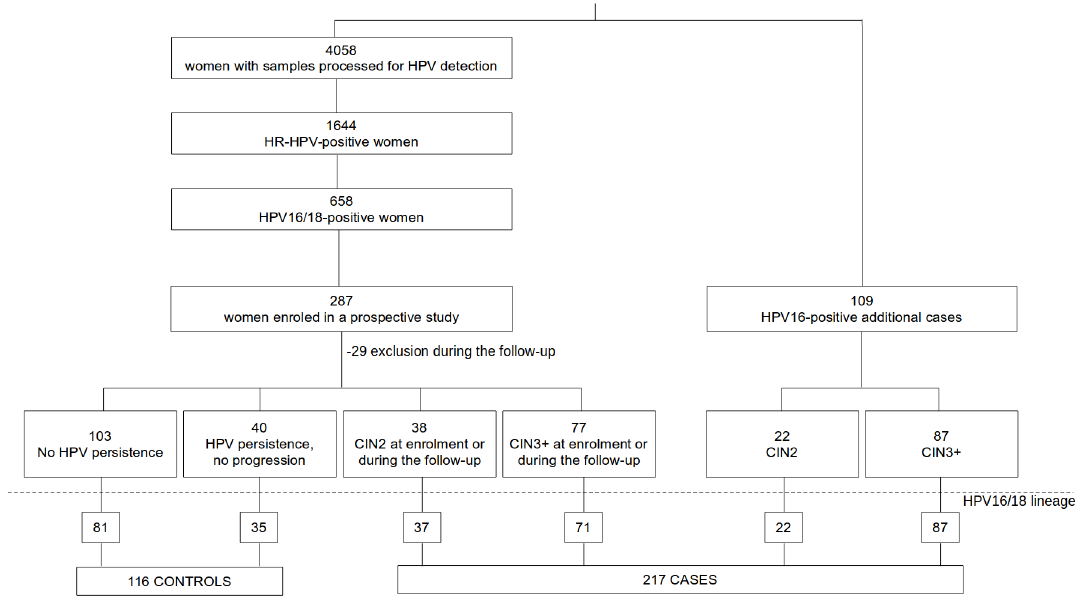
Figure 1. Study population. CIN2: Cervical intraepithelial neoplasia grade 2. CIN3 + includes CIN grade 3-carcinoma in situ , invasive squamous cell carcinoma, adenocarcinoma in situ , and adenocarcinoma. Controls for the analysis were women without progression to CIN2 or CIN3 + during the two-year follow-up of the prospective study of HPV16/18-positive women. Cases were women with histological diagnosis of HPV16/18-positive CIN2 or CIN3 + at enrolment or during the two-year follow-up of the prospective study. Enrolment of the prospective study: from 2009 to 2010. Additional cases were HPV16-positive CIN2 or CIN3 + cases collected from 2006 to 2008 and 2011 to 2012.